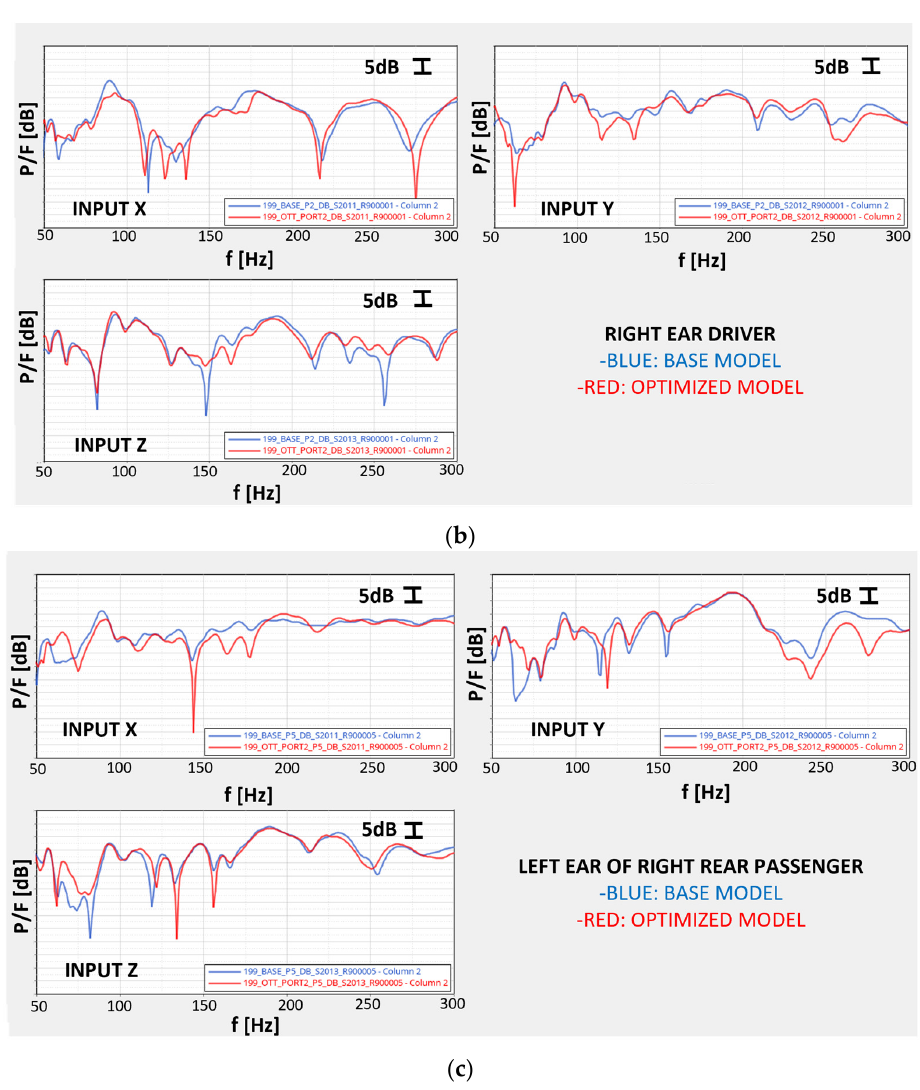
Figure 32. Vibrational excitation at anterior suspension attachment ( a ) and related transfer functions ( b , c ). The new optimized rear part configuration allows to obtain improved vibro-acoustic transfer functions, in correspondence of all excitations and of all virtual microphones, with respect to the original model (steel rear ring).